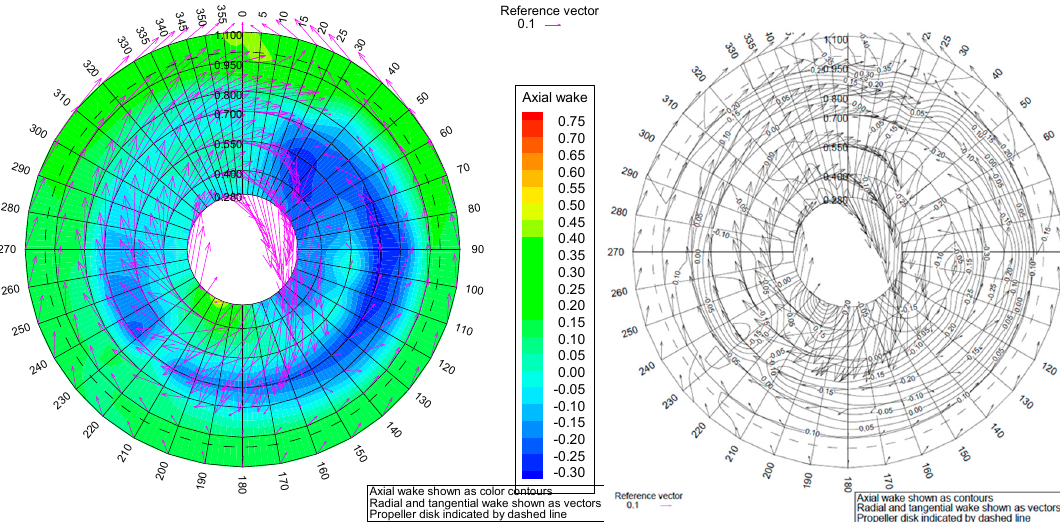
Figure 23. 3D wake measurements at a rudder stock plane (AP), with a working propeller, without PSS, at 14 kn.